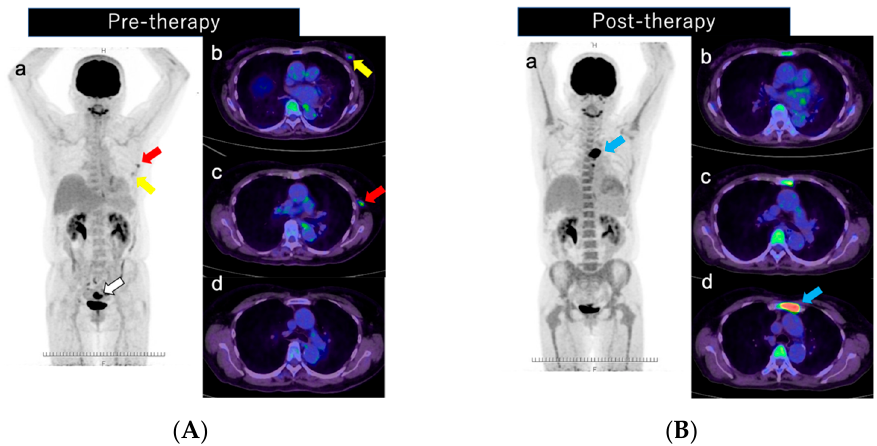
Figure 3. ( A ) Pre- and ( B ) post-therapy PET/CT imaging. ( A ) Pre-therapy imaging shows 18 F-FDG uptake in the left breast mass (SUV max, 3.0; (a,b): yellow arrow), a left axillary lymph node (SUV max, 4.2; (a,c): red arrow), and a uterine tumor (SUV max, 25.3; (a): white arrow). No other distant metastasis was observed (d). ( B ) Post-therapy imaging shows no abnormal uptake in the left breast or left axillary lymph node after NAC (a–c). There is strong localized FDG accumulation of a solitary new lesion in the sternum (SUV max, 30.6; (a,d): blue arrow).